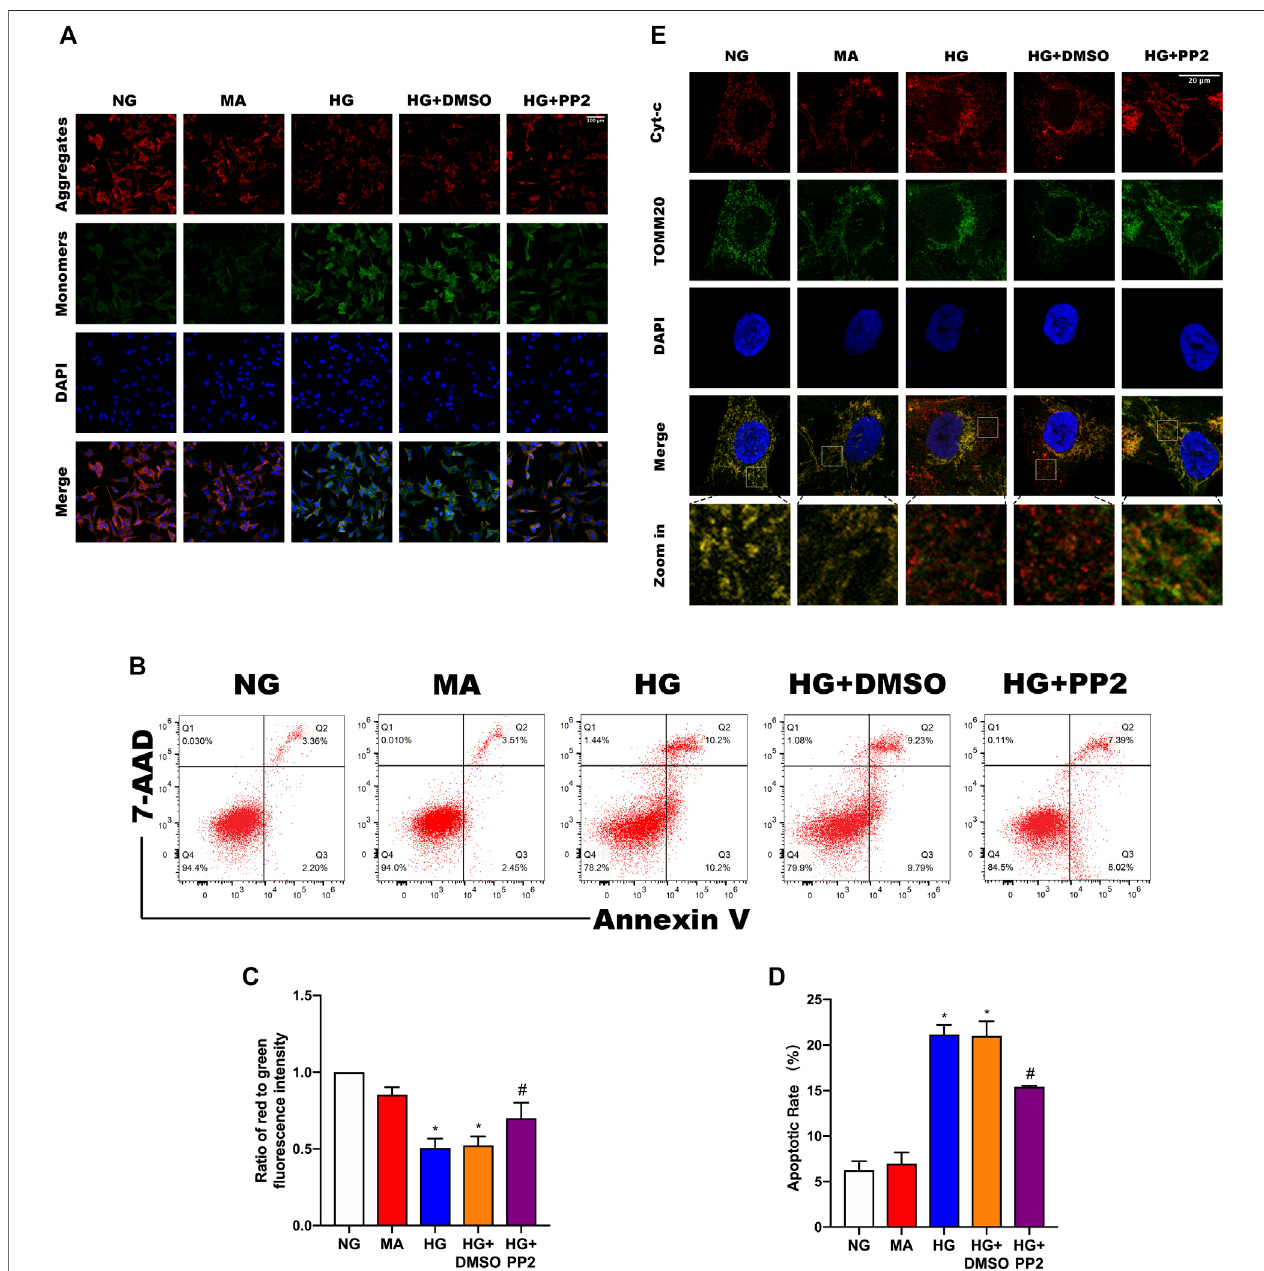
FIGURE 5 | Src activation is related to podocyte mitochondrial apoptosis. (A) JC-1 staining to observe mitochondrial membrane potential changes in podocytes after the indicated treatments. Red fl uorescence represents normal, functioning mitochondria while green fl uorescence indicates collapsed mitochondrial membrane potential. (Magni fi cation, 200 ×). (B) Flow cytometric detection of podocyte apoptosis rates. (C) MMP measured as the ratio of red to green fl uorescence intensity from (A) . (D) Quantitationofpodocyteapoptosisfrom (B) . (E) Doubleimmuno fl uorescencelabelingofCyt-c(red)andTOMM20(green)inpodocytes,nucleilabeledwith DAPI (blue) (Magni fi cation, 1000 ×). Values are expressed as the mean ± SD, * p < 0.05 vs. NG group, # p < 0.05 vs. HG group.